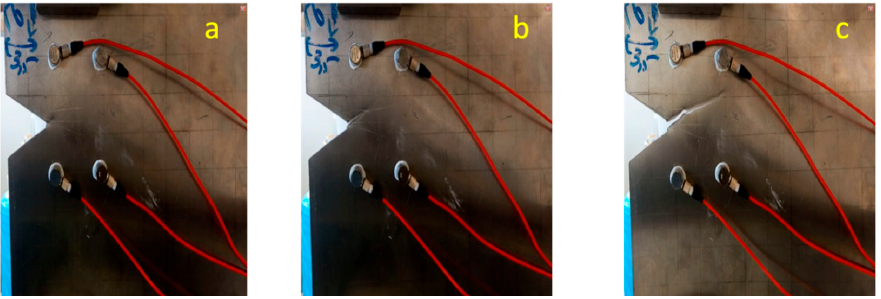
Figure 9. Evolution of the crack at the first ( a ) second ( b ) third ( c ) sudden increase of the AE signals which happen at 𝑡 ≈ 160 s , 𝑡 ≈ 215 s and 𝑡 ≈ 270 s , respectively.